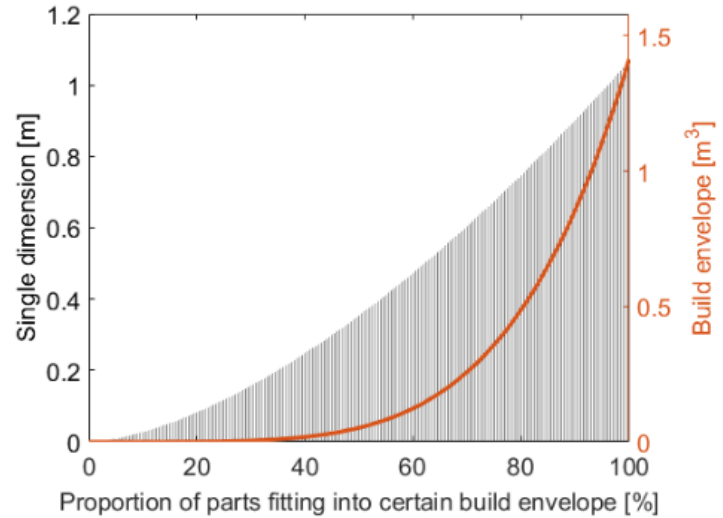
Figure 3. Technical barrier analysis of limited build chamber volumes for demanded spare part sizes.